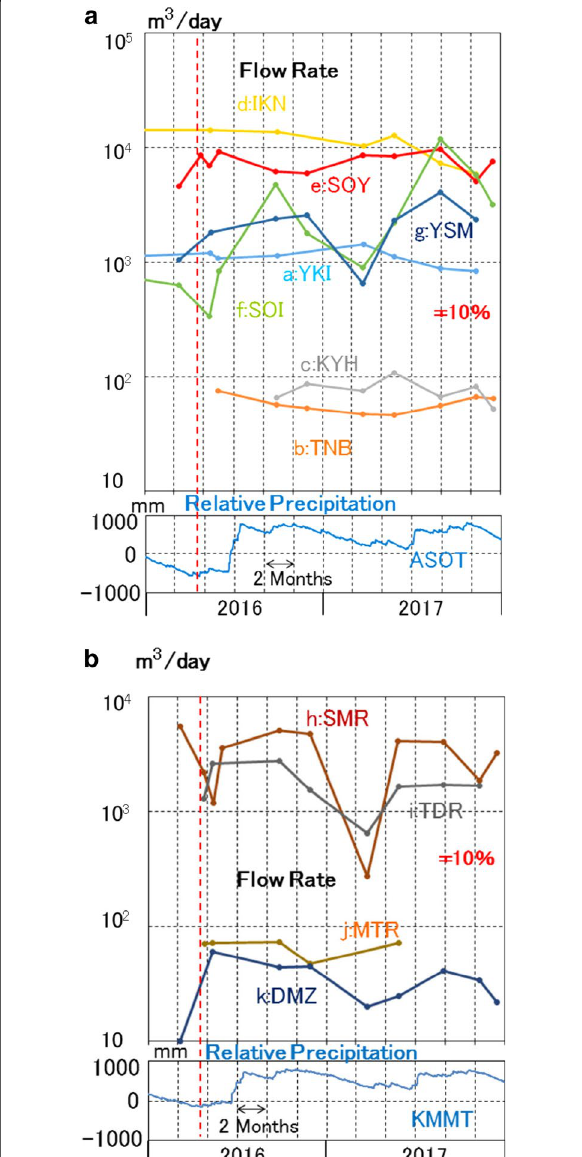
Fig. 7 a Flow rate changes at the springs a:YKI, b:TNB, c:KYH, d:IKN, e:SOY, f:SOI, and g:YSM and the relative precipitation at ASOT during the period from 2016 to 2017. The flow rate was manually measured and its precision was estimated to be about a few to 10%. Vertical red broken line indicates the occurrence of the main shock of the 2016 Kumamoto earthquake. At the springs a:YKI, d:IKN, e:SOY, f:SOI, and g:YSM, the flow rate was measured before the 2016 Kumamoto earthquake. Before 2016 at a:YKI, d:IKN, and f:SOI, the flow rate was respectively measured on February 1, 2014; September 6, 2014; and February 1, 2014. b Flow rate changes at the springs h:SMR, i:TDR, j:MTR, and k:DMZ and the relative precipitation at KMMT during the period 2016–2017. The precision is about a few to 10%. Vertical red broken line indicates the occurrence of the main shock of the 2016 Kumamoto earthquake. At the springs h:SMR and k:DMZ, the flow rate was measured before the 2016 Kumamoto earthquake